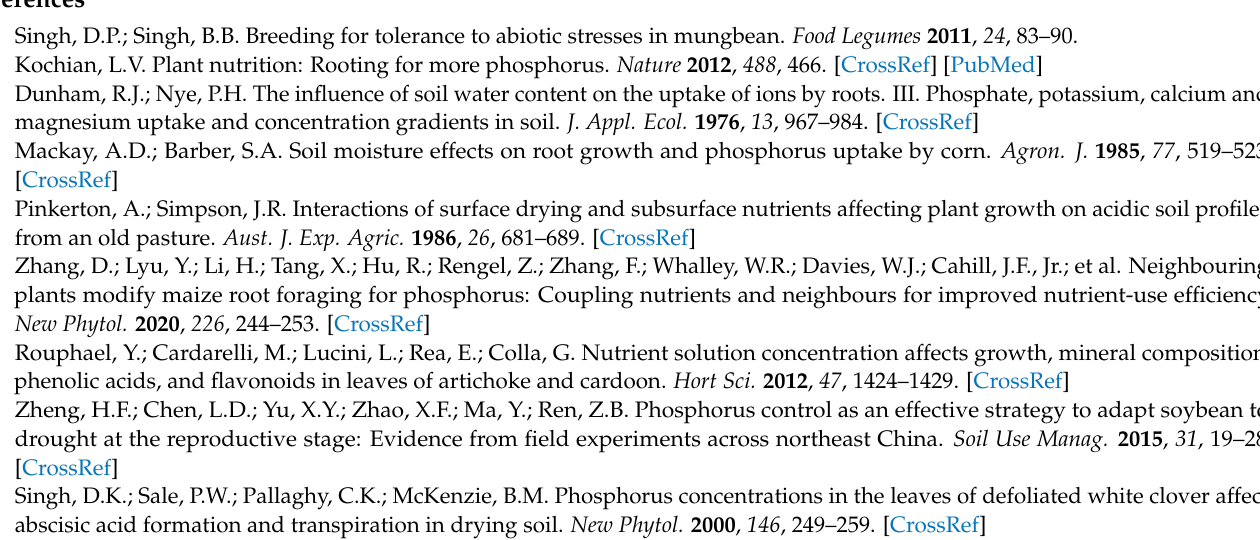
and combined stresses. Table S4: The significance of sources of variability for accessions (G, 10), phosphorus (P, 2 levels), moisture (W, 2 levels), and their interaction effects on growth and yield traits